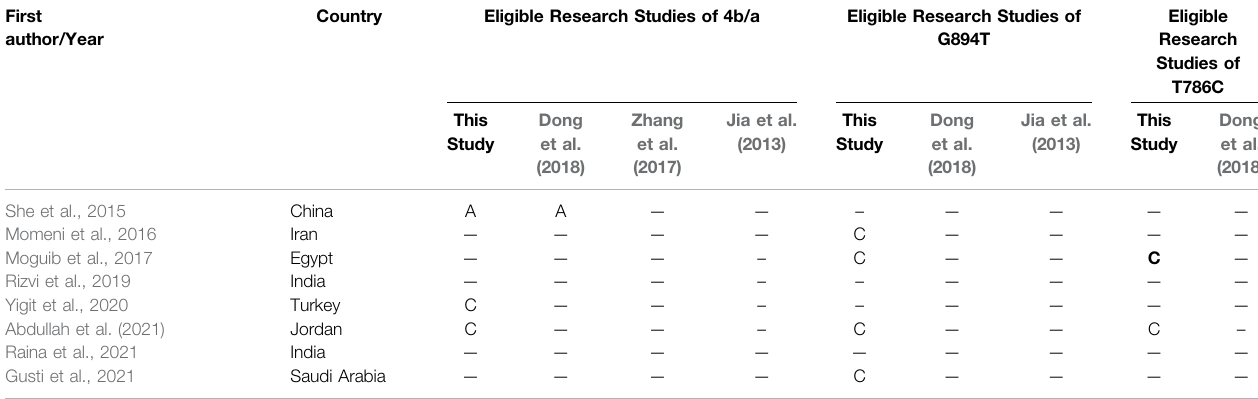
Figure 2 ). Also, similar association was also found in the healthy control and matched studies ( Table 6 ).